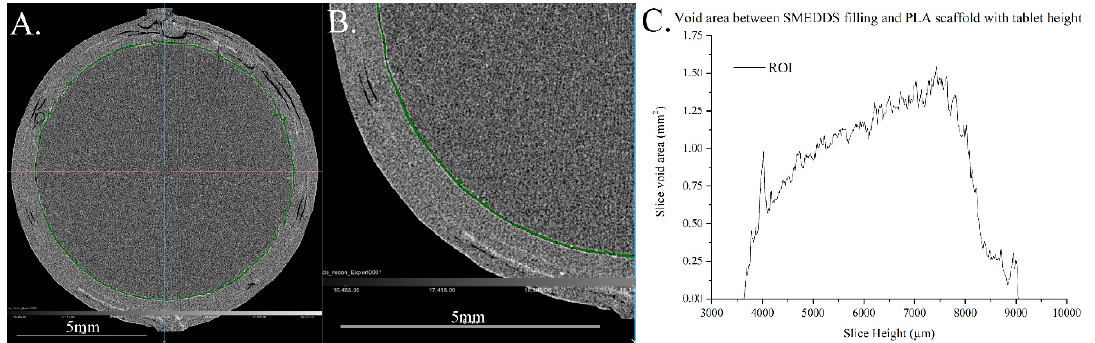
Figure 6. Horizontal cross-section images acquired via X-ray CT imaging of a FEN-loaded PLA PLH, with void area ROI highlighted in green. (A) Full scale cross-section image at slice 505, (B) single quadrant cross-section image at slice 505. (C) Area analysis (mm 2 ) of ROI with increasing slice height (µm) of a FEN-loaded PLA-based PLH.